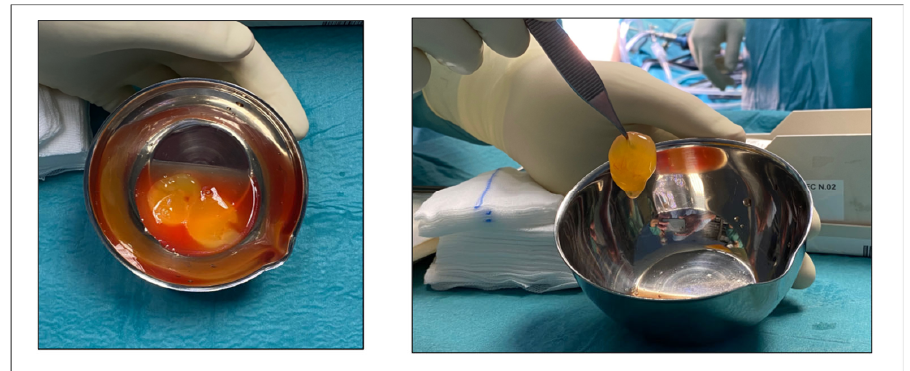
Figure 3. The autologous platelet-rich fibrin matrix (PRFM).